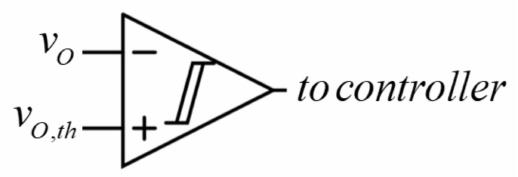
Figure 6. SCS connection timing